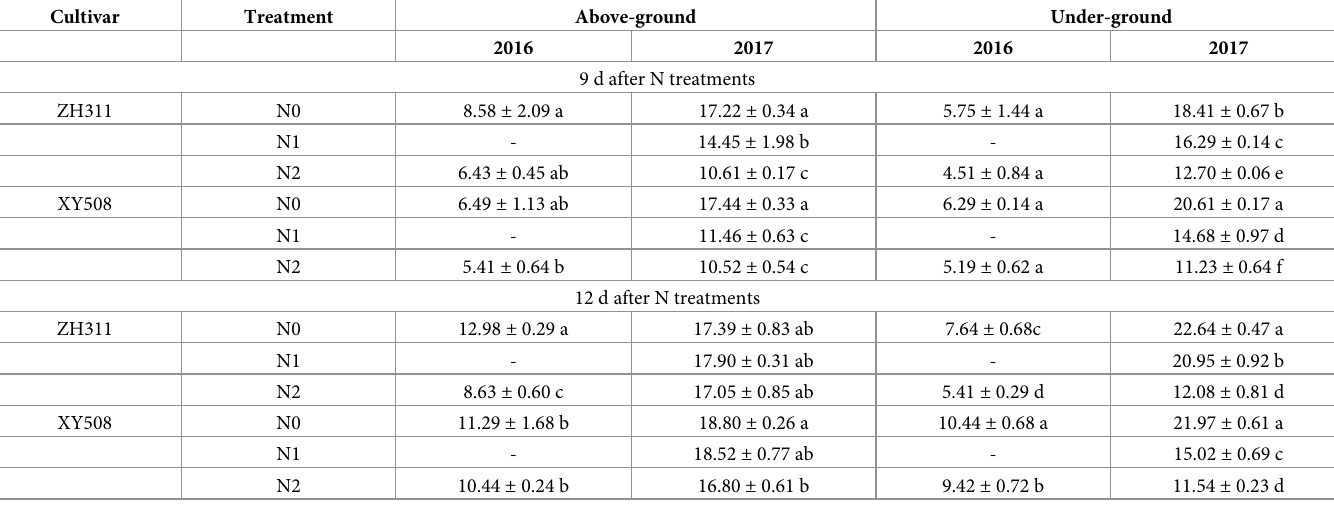
Table 3. Starch content in maize at the seedling stage under different nitrogen treatments (mg g -1 ).